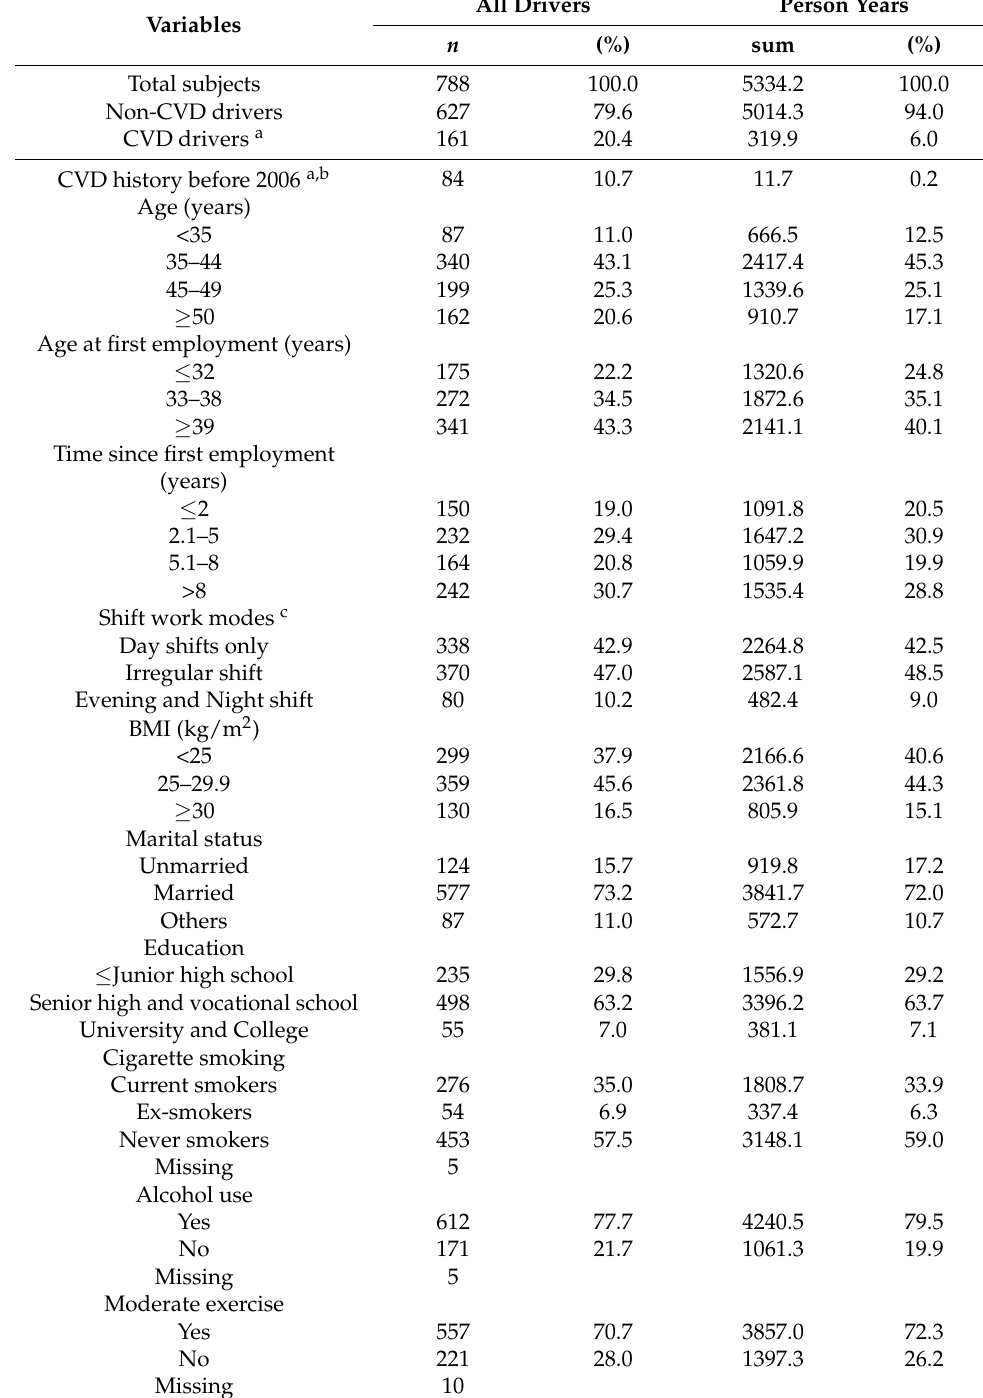
Table 1. Baseline characteristics of the study